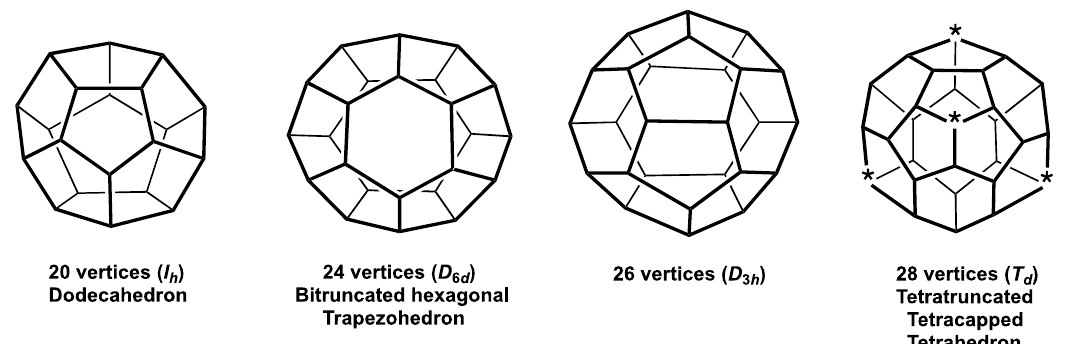
Figure 6. The most spherical trivalent polyhedra with 8, 10, 12, 14, and 16 vertices as duals of the closo deltahedra in endohedral Group 14 clusters.